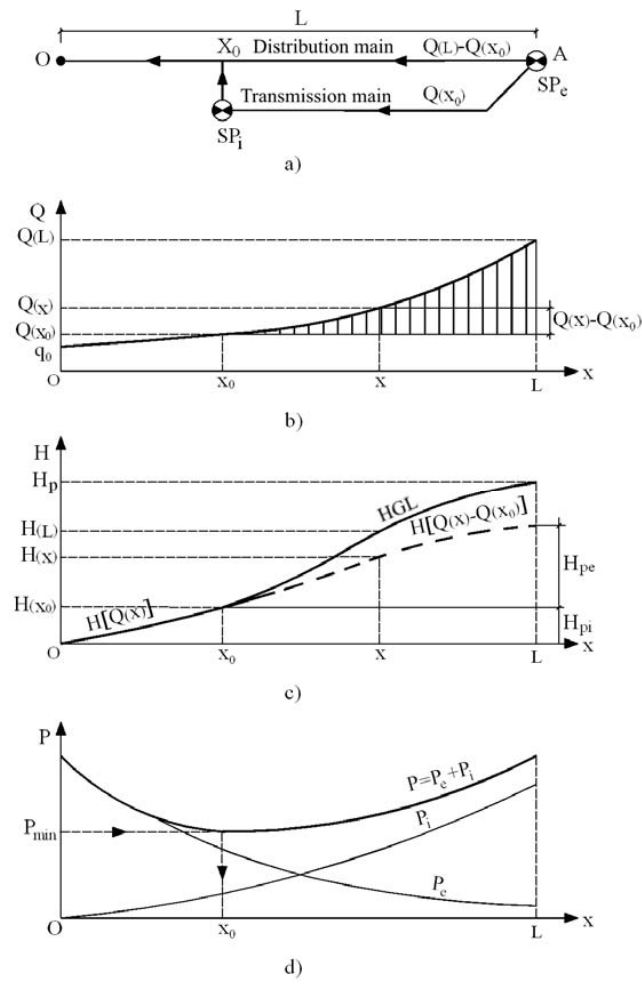
Figure 4. Optimal location of a pumped storage tank. ( a ) Schematic of the distribution main; ( b ) Discharge distribution; ( c ) Head loss variation; ( d ) Power variation of the external and internal pump stations.